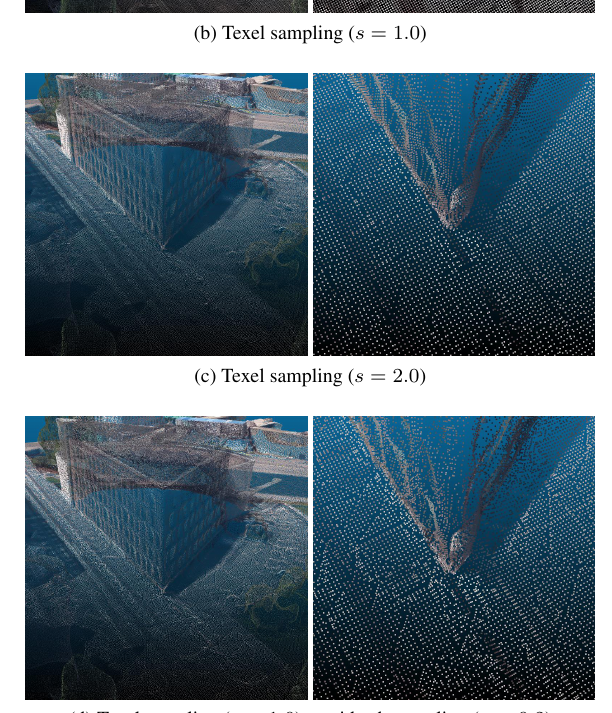
Figure 2. Sampling methods comparison.